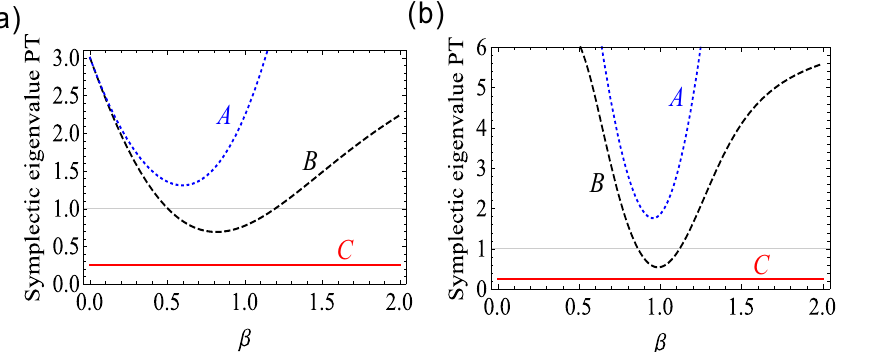
Figure 7. The dependence of smallest symplectic eigenvalues E ˆ on feedforward gain β under the conditions of η = 1 and G 1 = G 2 = G 3 = 2 in ( a ) , G 1 = G 2 = G 3 = 20 in ( b ).